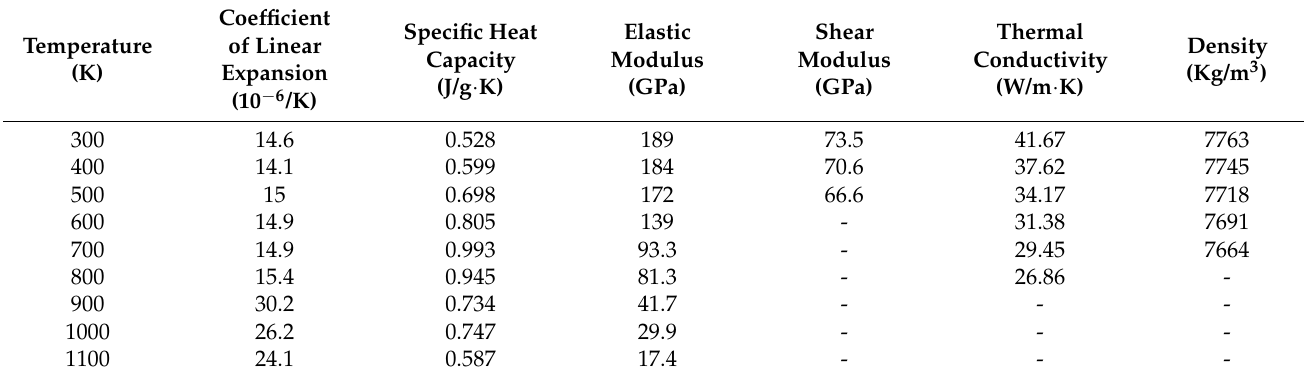
Table 2. Thermophysical parameters of Cr5 steel.